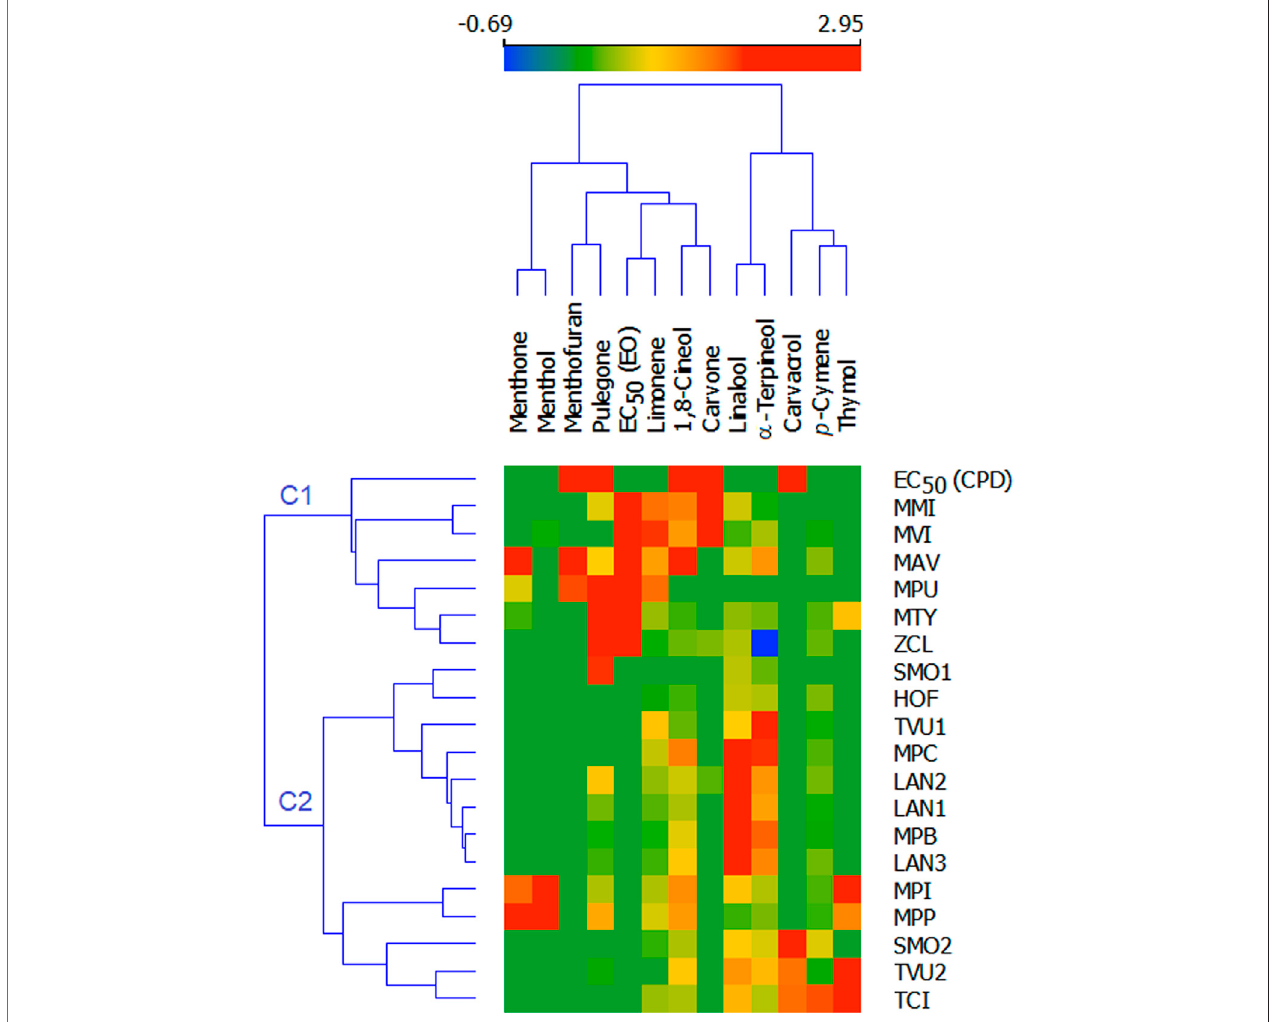
FIGURE 7 | Heatmap of antiviral activity of selected monoterpenes and essential oils against Sars-Cov-2. MAV — Mentha aquatica “ Veronica ” ; MPU — Mentha pulegium ; MMI — Mentha microphylla ; MVI — Mentha vilosa ; MPI — Mentha x piperita ; MPB — Mentha x piperita “ Bergamot ” ; MPP — Mentha x piperita ‘ Perpeta ’ ; MPC — Mentha x piperita “ Citrata ” ; TVU1 — Thymus vulgaris 1; TVU2 — Thymus vulgaris 2 ; TCI — Thumys x citriodorus ; LAN1 — Lavandula augustifolia 1; LAN2 — Lavandula augustifolia 2; LAN3 — Lavandula augustifolia 3; SMO1 — Satureja montana 1; SMO2 — Satureja montana 2; MTY — Micromeria thymifolia ; HOF — Hyssopus of fi cinalis ; ZCL — Ziziphora clinopodioides . EC 50 (CPD) — effective antiviral activity of single compound; EC 50 (EO) — effective antiviral activity of essential oil.